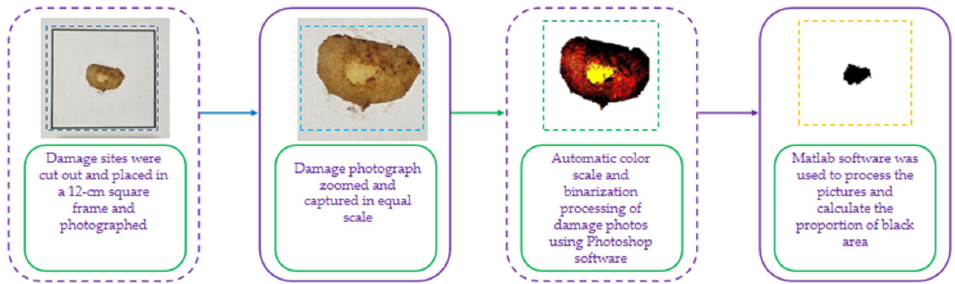
Figure 3. Flow chart of photo processing of potato damage.